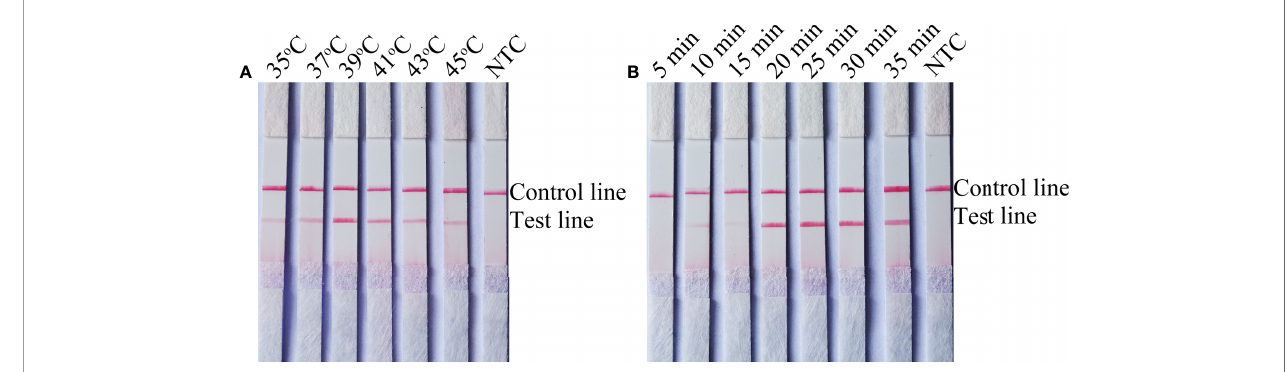
FIGURE 2 | Screening of optimal temperature and time parameters for the C. tropicalis RPA-LFS system. (A) Performance of C. tropicalis RPA-LFS at temperatures ranging from 35°C to 45°C. (B) Performance of C. tropicalis RPA-LFS at times ranging from 5 min to 35 min. NTC lane is a no-template